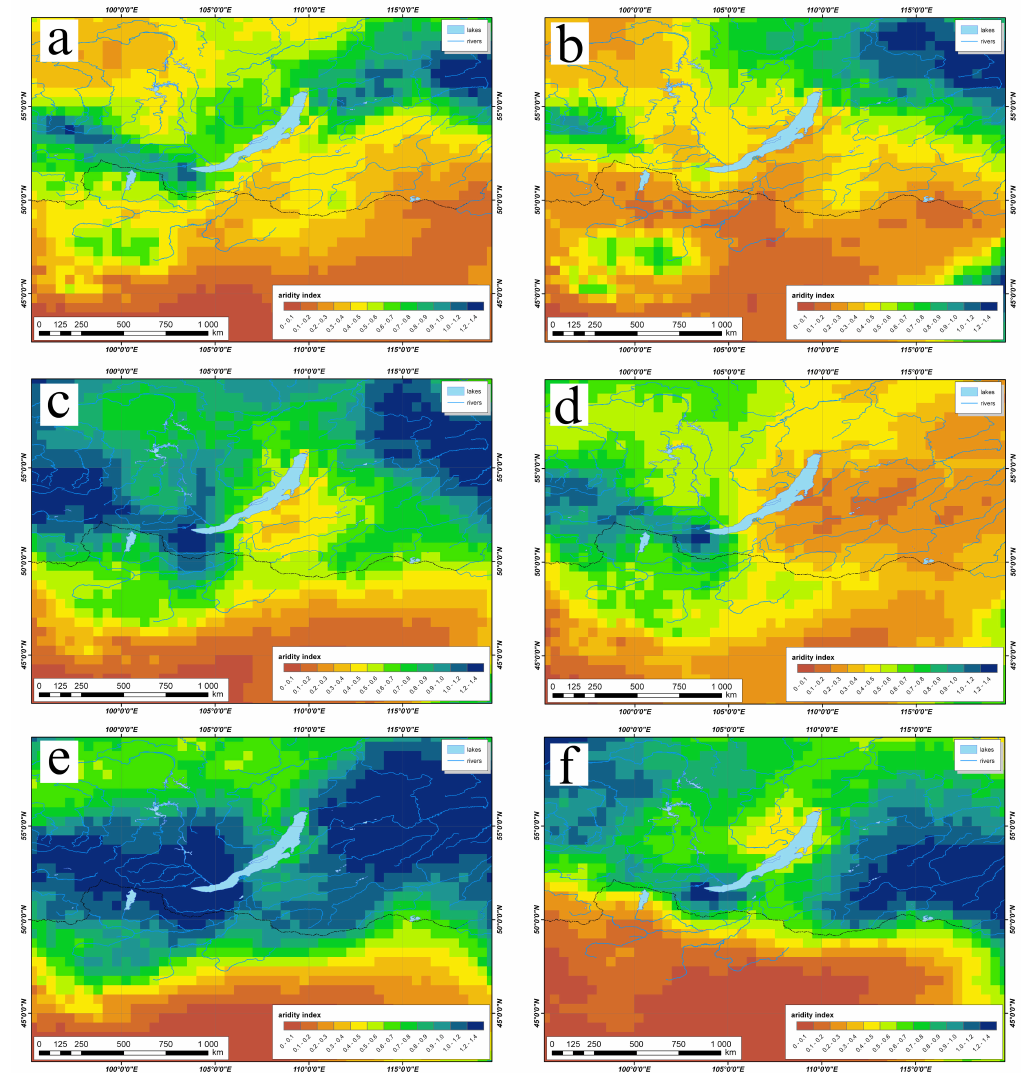
Figure 10. The comparison between the spatial distribution of aridity index in the relatively wet 2010 summer ( a , c , e ) and in the abnormally dry 2015 summer ( b , d , f ). Panels ( a , b ) correspond to June, ( c , d ) correspond to July, and ( e , f ) correspond to August. The aridity index was calculated based on the CRU TS climatic